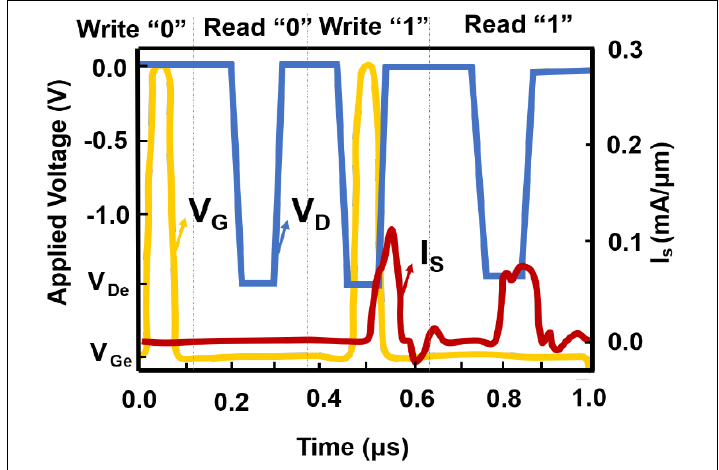
Figure 10. Illustrated waveform of a capacitor-less DRAM’s operation. The DRAM is composed of a Z 2 -FET with V BG = 2 V [43,44].